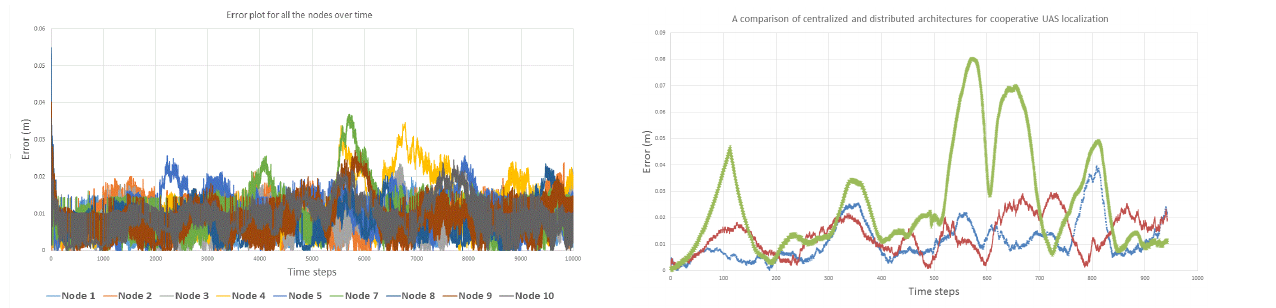
Figure 7: Error comparison for the position of a node when po- sition information is shared by the node and there is no GNSS on-board for the case of centralized vs distributed